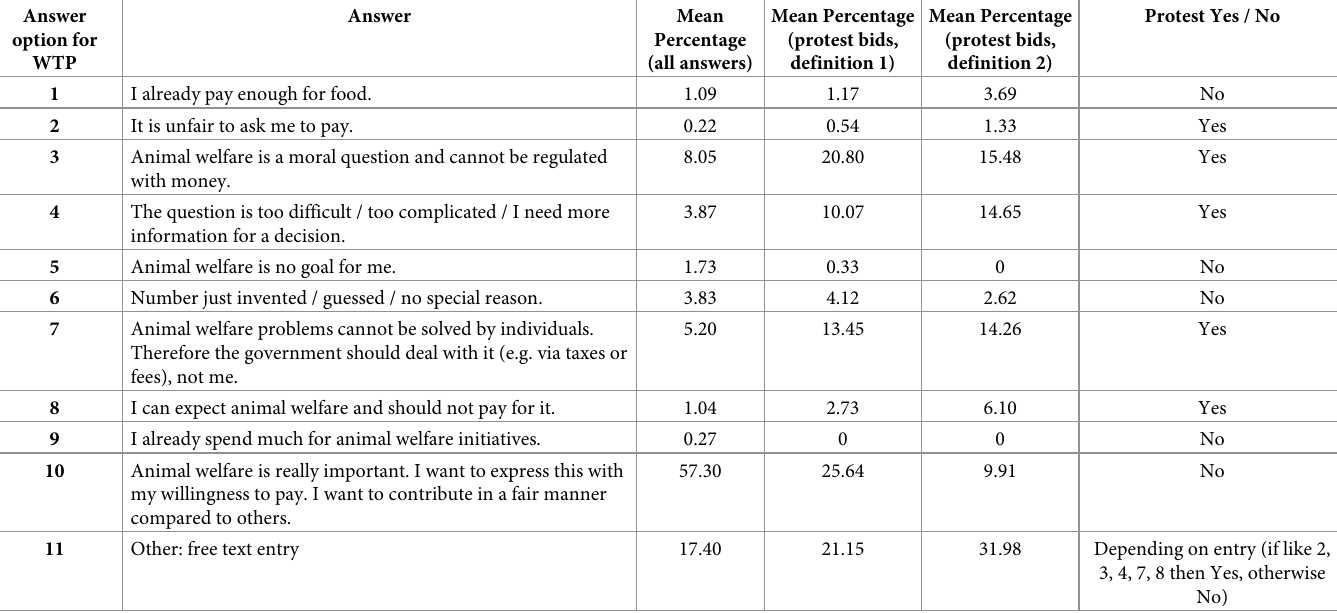
Table 1. Answer options, percentages for answers given and coding as protest response for reasons for WTP questions.